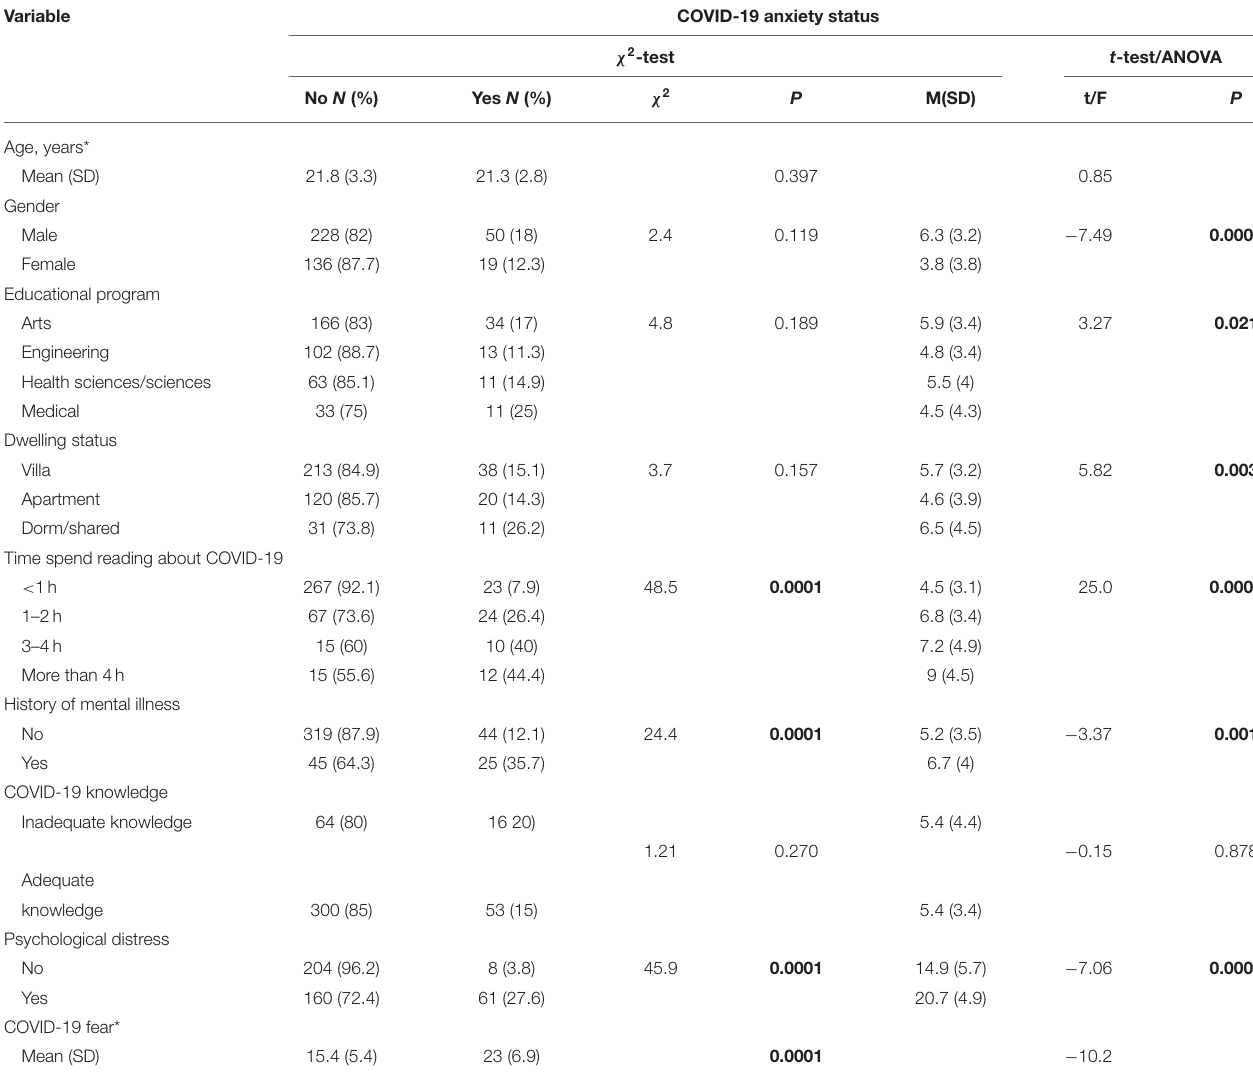
TABLE 3 | Association and differences between anxiety and demographic variables, knowledge, psychological distress, fear.